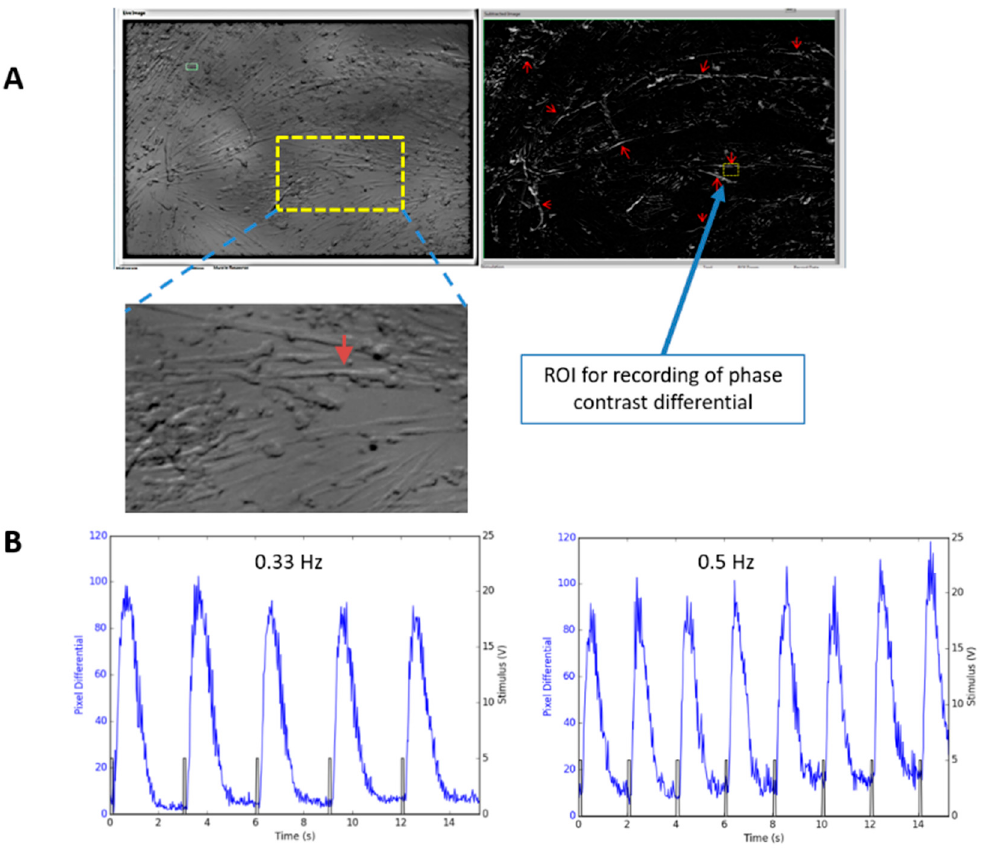
Figure 6. Recording of myotube contraction by measuring pixel differentials under phase contrast microscope. ( A ) Recording of a myotube contraction in a Day 14 culture (D10 in Differentiation) was performed by motion capture of the myotubes using a custom LabVIEW program. Left image in A is a regular phase image. The right is a phase differential image in which all the contracting myotubes “light up” due to the phase contrast change caused by motions. Red arrows point to some of the contracting myotubes where synchronous motion was detected upon stimulation indicating they were contracting. An enlarged image of the recorded myotube was included as an inset. An ROI (Region of Interest) was chosen on one of the contractible myofibers for monitoring myofiber contraction under electrical stimulation. ( B ) Contraction recording from one myofiber under two stimulation frequencies are illustrated as an example.